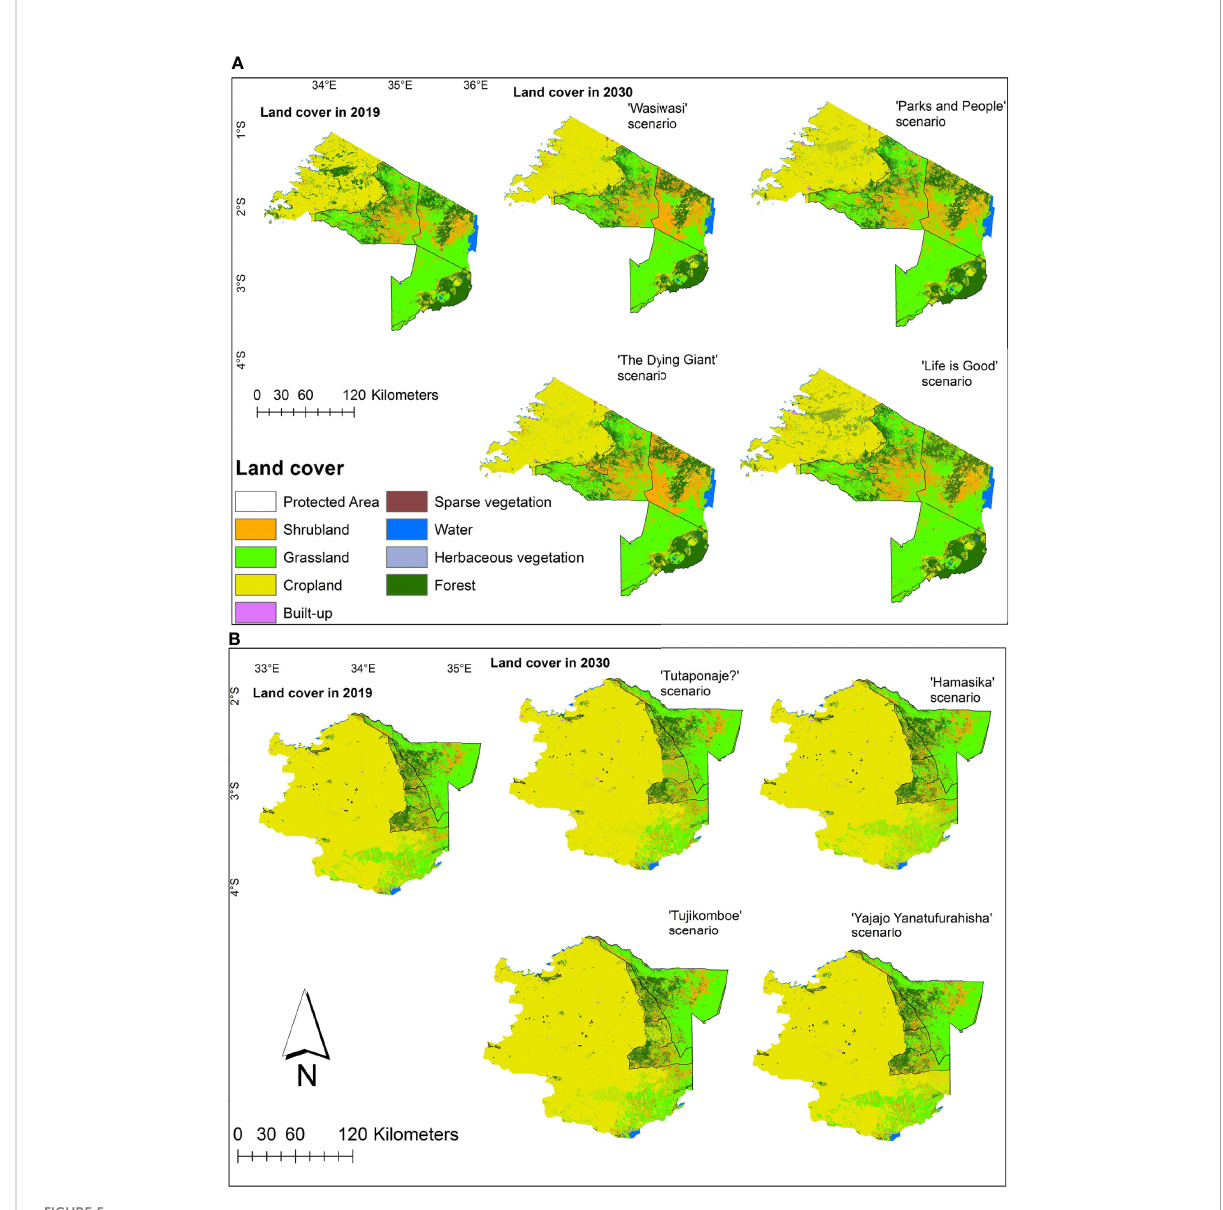
FIGURE 5 (A) Land cover change maps for northern and eastern Serengeti from 2019 to 2030 under the Wasiwasi, Parks and People, The Dying Giant, Life is Good scenarios. (B) Land cover maps for southern and western Serengeti from 2019 to 2030 under the Tutaponaje?, Hamasika, Tujikomboe, and Yajayo